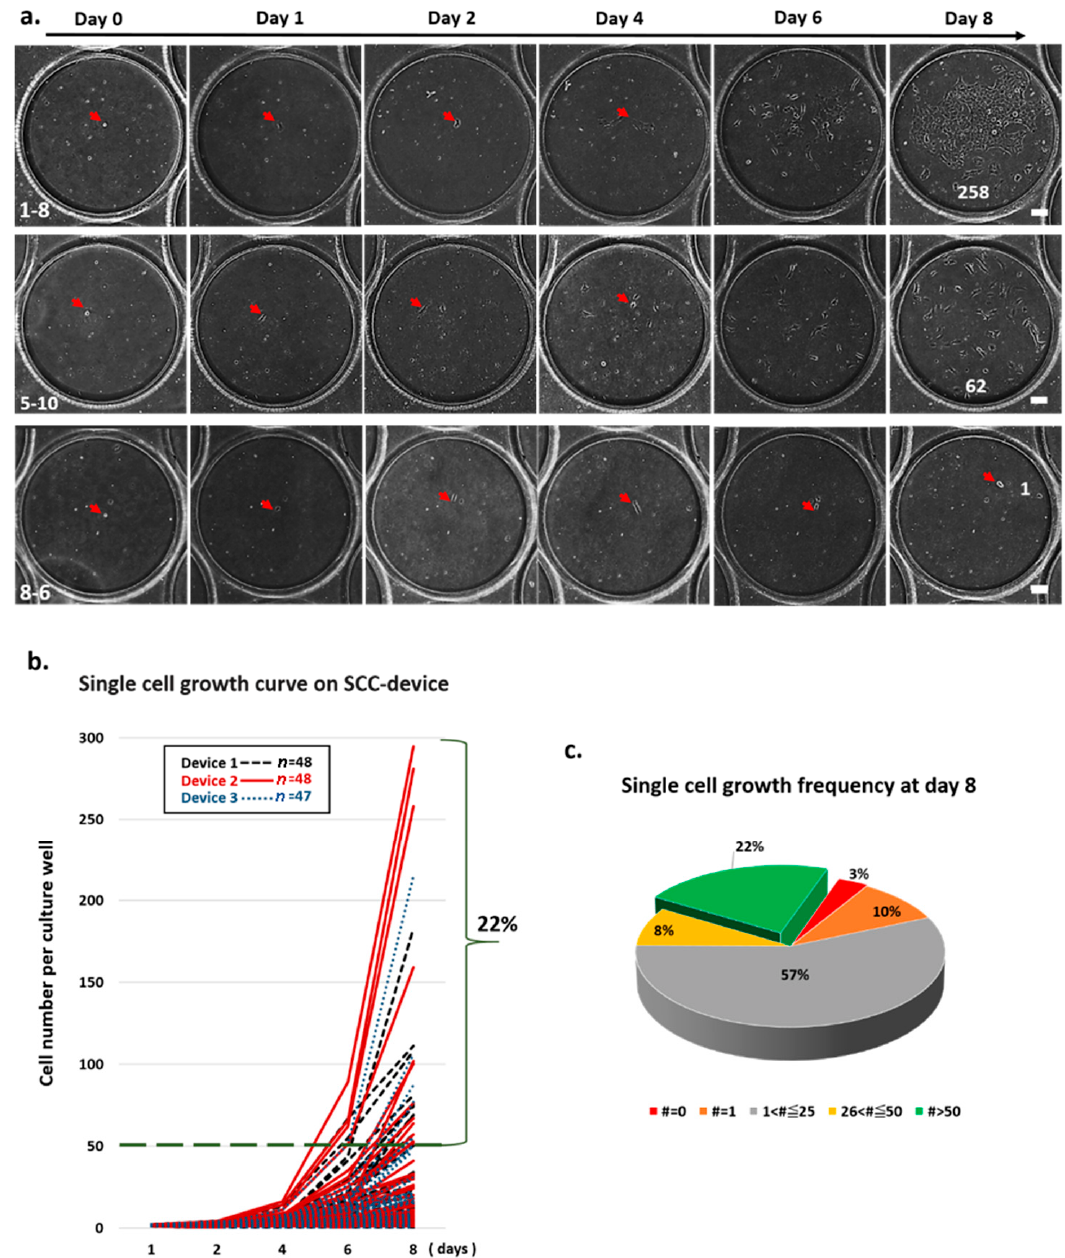
Figure 3. Validation of single cell’s morphology and cell growth in an SCC device. ( a ) Time-course images from the clone well show cell growth on the SCC device over time. ( b ) Single-cell division in each well was monitored and counted using scanned images from day 0 to 8. Of the single-cell-derived colonies, 22% proliferated to more than 50 cells and formed a cluster. ( c ) Frequency of cell growth on day 8 is represented as a pie graph. Each color represents the number (#) of cells counted on day 8.